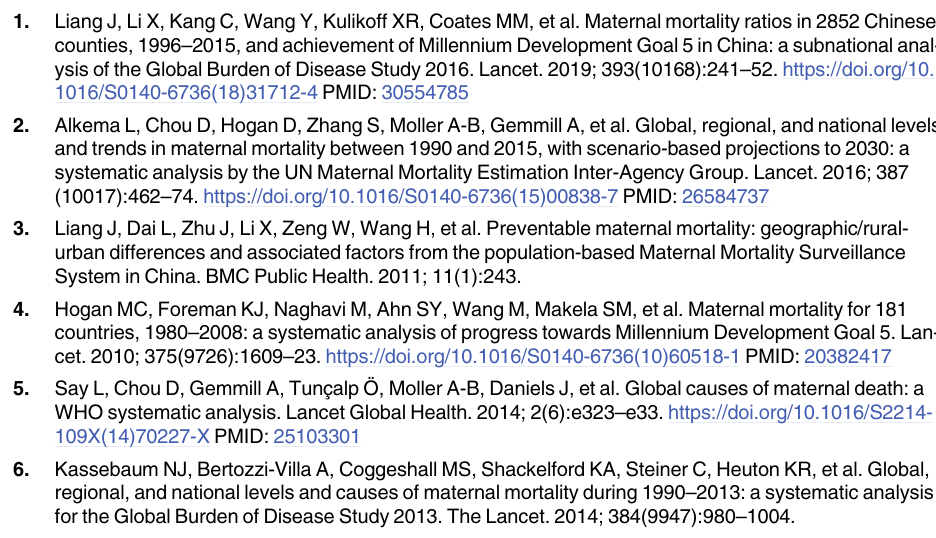
S2 Fig. Illustration of China’s 3 regions—Eastern and southern coastland, central and northern regions, and western and southwestern